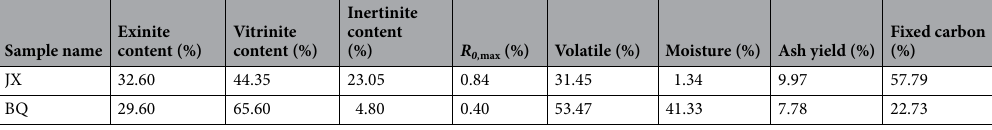
Table 1. Results of proximate analysis and maceral of different